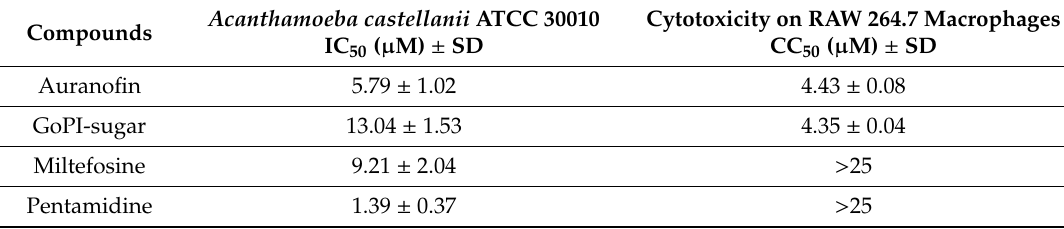
Table 9. In vitro activities of gold(I) complexes against A. castellanii and RAW 264.7 macrophages.